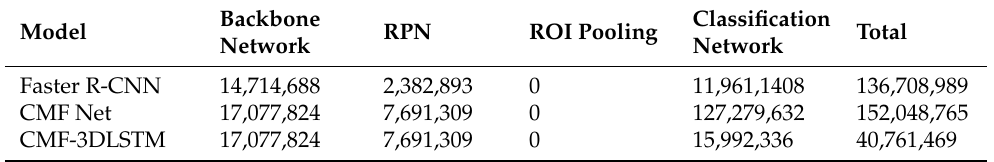
Table 2. Experimental environment.